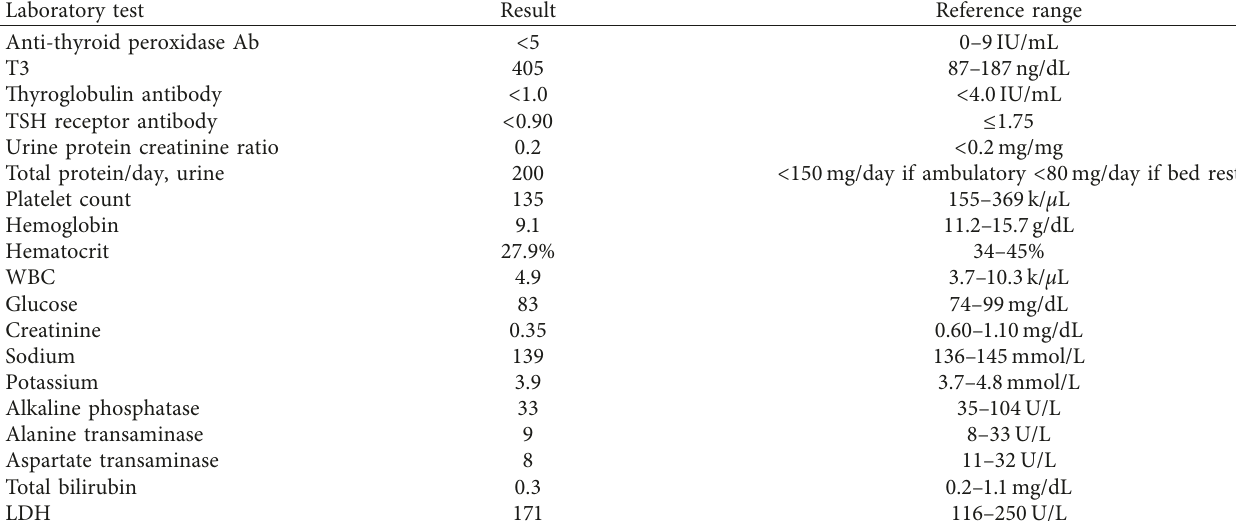
Table 1: Laboratory evaluation on admission.